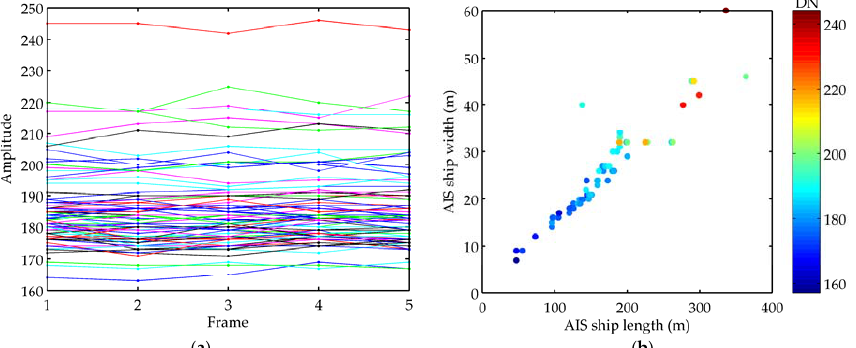
Figure 5. Amplitude information of ships. ( a ) Amplitudes of tracked ships in five frames. Different colored lines represent different ships; ( b ) Mean amplitudes of tracked ships compared with the sizes of ships verified by AIS data. Sensors 2018 , 18 , x FOR PEER REVIEW